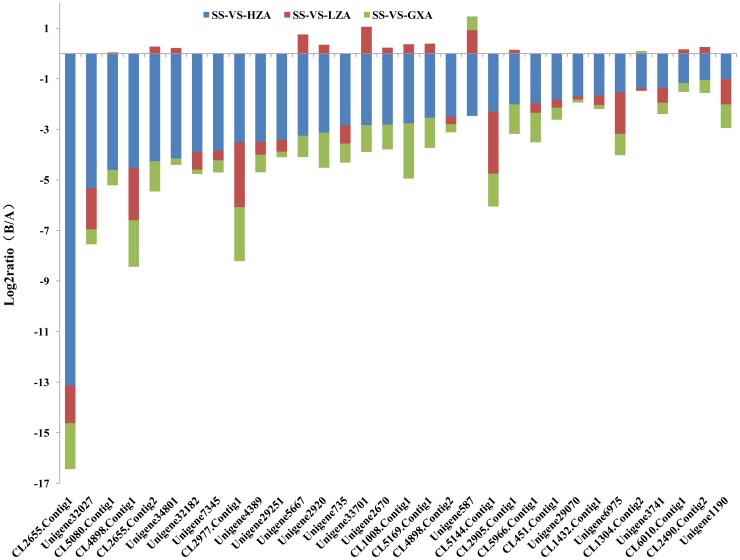
The expression trend and level of genes involved in the calcium signaling pathways of P. xylostella.